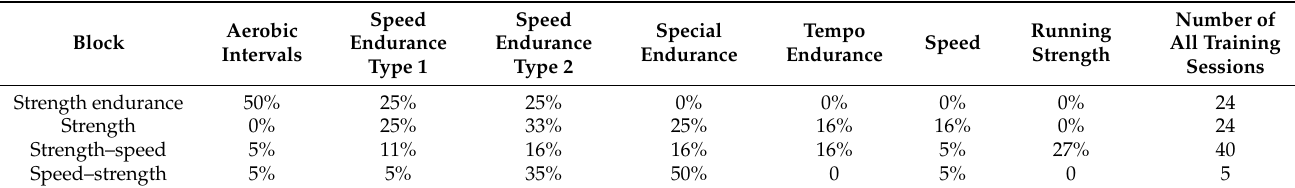
Table 4. Distribution and number of running sessions in each block throughout 16